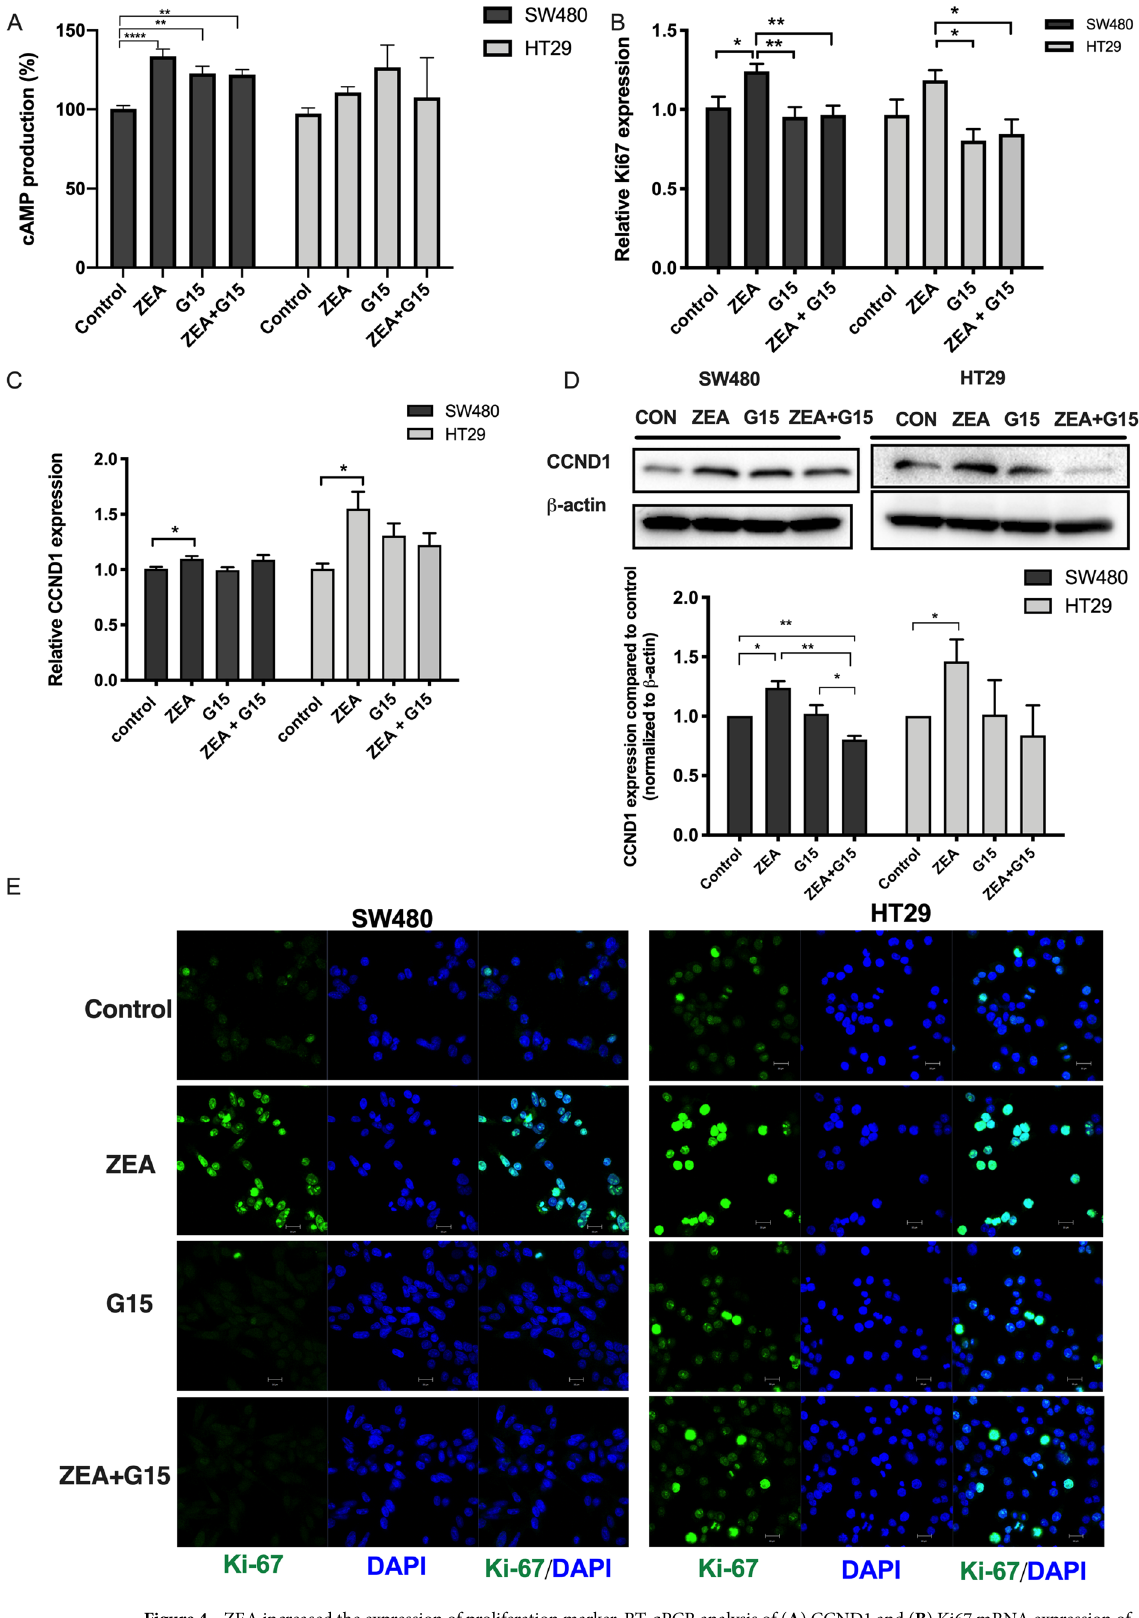
Figure 4. ZEA increased the expression of proliferation marker. RT-qPCR analysis of ( A ) CCND1 and ( B ) Ki67 mRNA expression of SW480 and HT29 incubated with 3 μM ZEA with or without G15 (GPER antagonist). ( C ) cAMP production induced by 3 μM ZEA in the absence or presence of 5 μM G15. cAMP production was analysed by comparing the cAMP production to control group as 100%. ( D ) Western blot analysis of CCND1 protein expression, ( E ) Ki-67 expression was determined by immunofluorescence staining for Ki67 (green) along with DAPI for DNA (blue). Scale bar, 20 μm. Results shown are mean ± SEM, with n = 3. *p < 0.05 and **p <